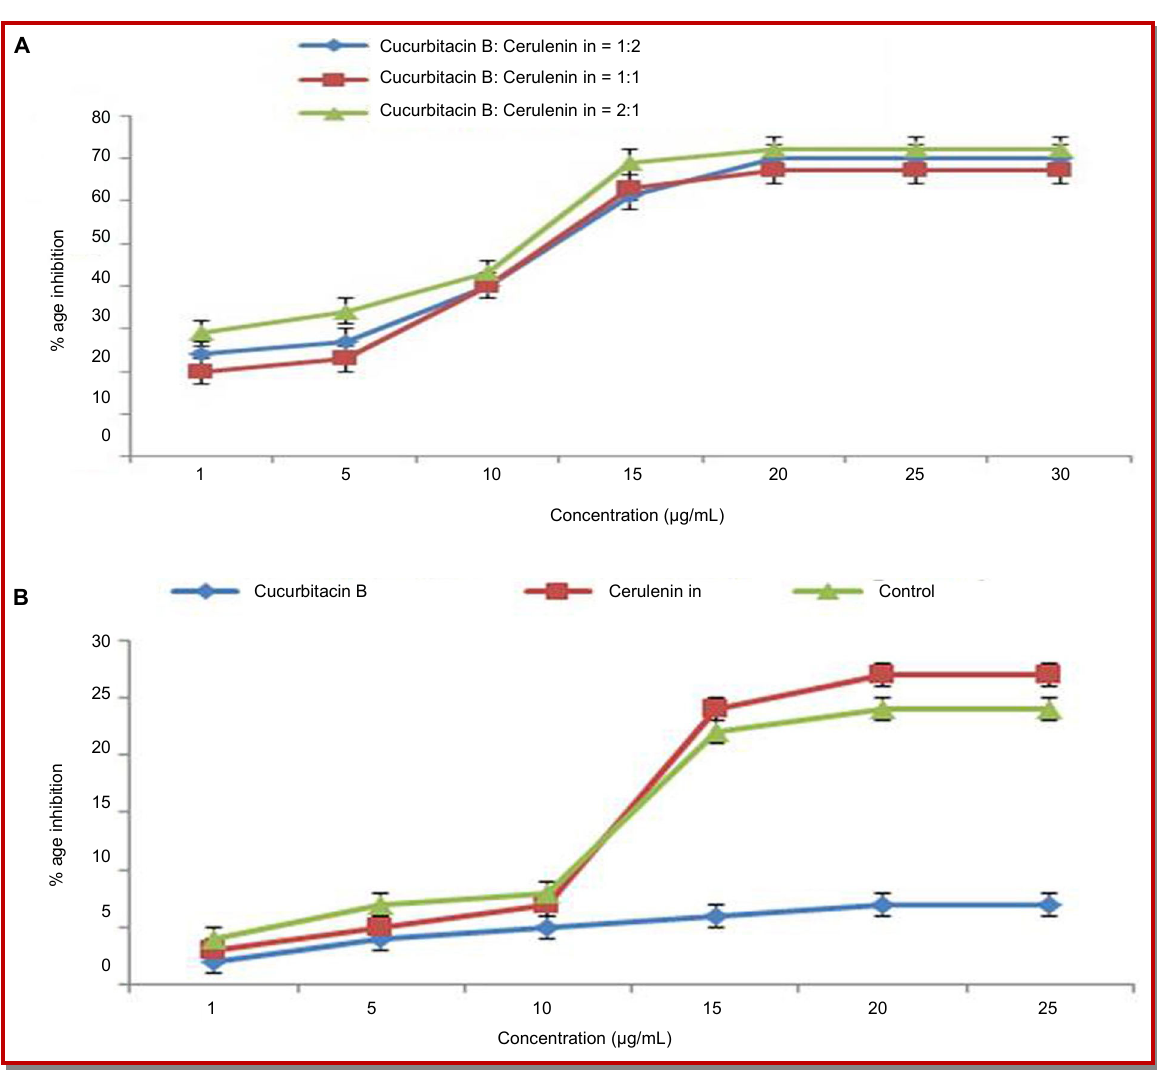
Figure 2: Inhibitory effect of cucurbitacin B, cerulenin or combination treatment on the growth of Saos-2 cells. (A) Cucurbitacin B and cerulenin both inhibited Saos-2cell growth in a dose-dependent manner. (B) Cucurbitacin B was applied to Saos-2 cells ad- junctively with cerulenin in a proportion of 1:1, 1:2 and 2:1. The adjunctive treatment also inhibited Saos-2 cell growth in a dose- dependent